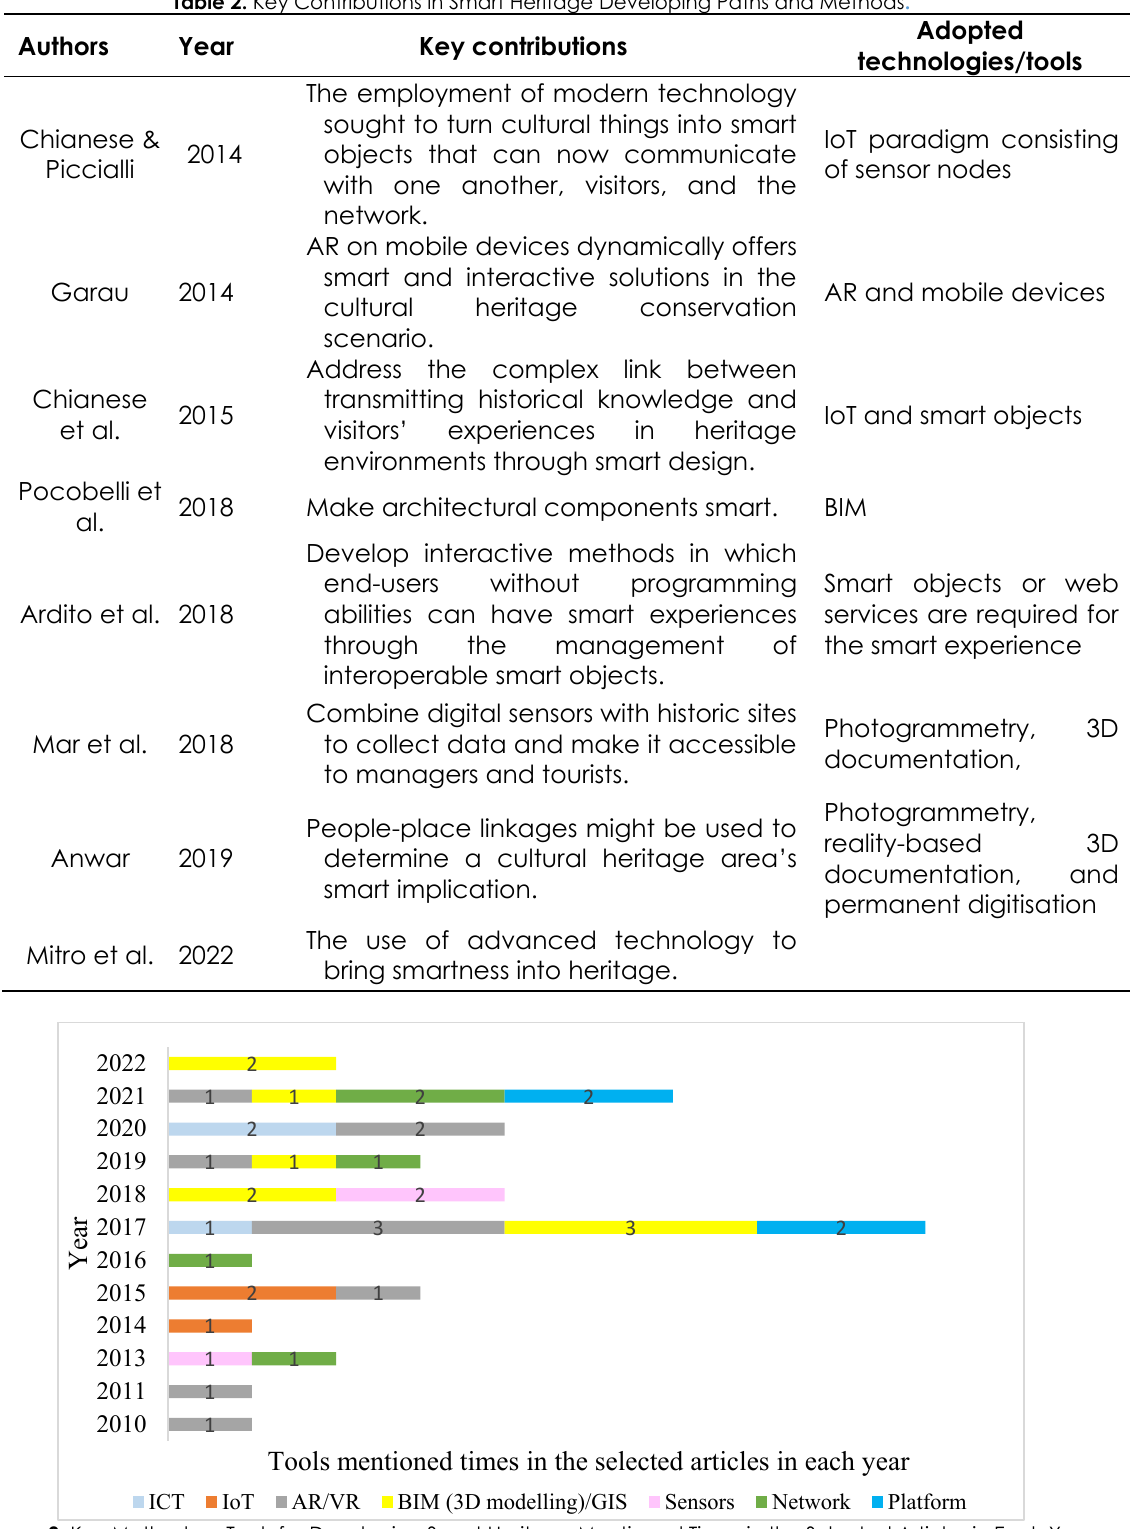
Figure 2. Key Methods or Tools for Developing Smart Heritage Mentioned Times in the Selected Articles in Each